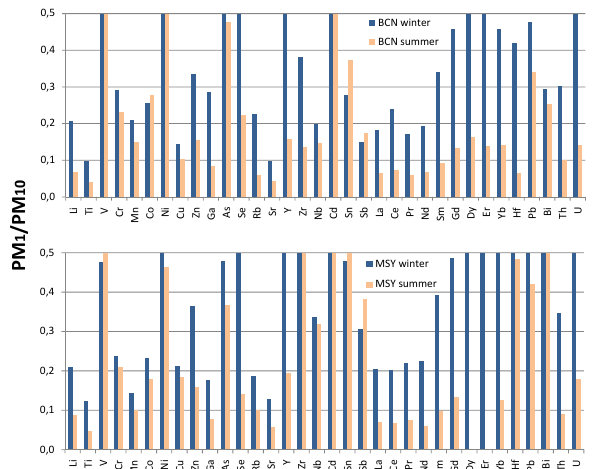
Fig. 7. PM 1 /PM 10 ratios of average trace metal concentrations measured in BCN and MSY during the summer and winter cam- paigns. Metals especially concentrated in the finer fraction in BCN (PM 1 /PM 10 > 0.5) include V, Ni and Cd for both summer and win- ter. In contrast, metals in the coarser fraction (PM 1 /PM 10 < 0.1) are mostly crustal elements such as Ti and Sr, Li, Ga and some REE. In MSY winter samples showed more metals in the fine fraction than in summer, with coarse metalliferous PM (PM 1 /PM 10 < 0.1) only being observed in the summer